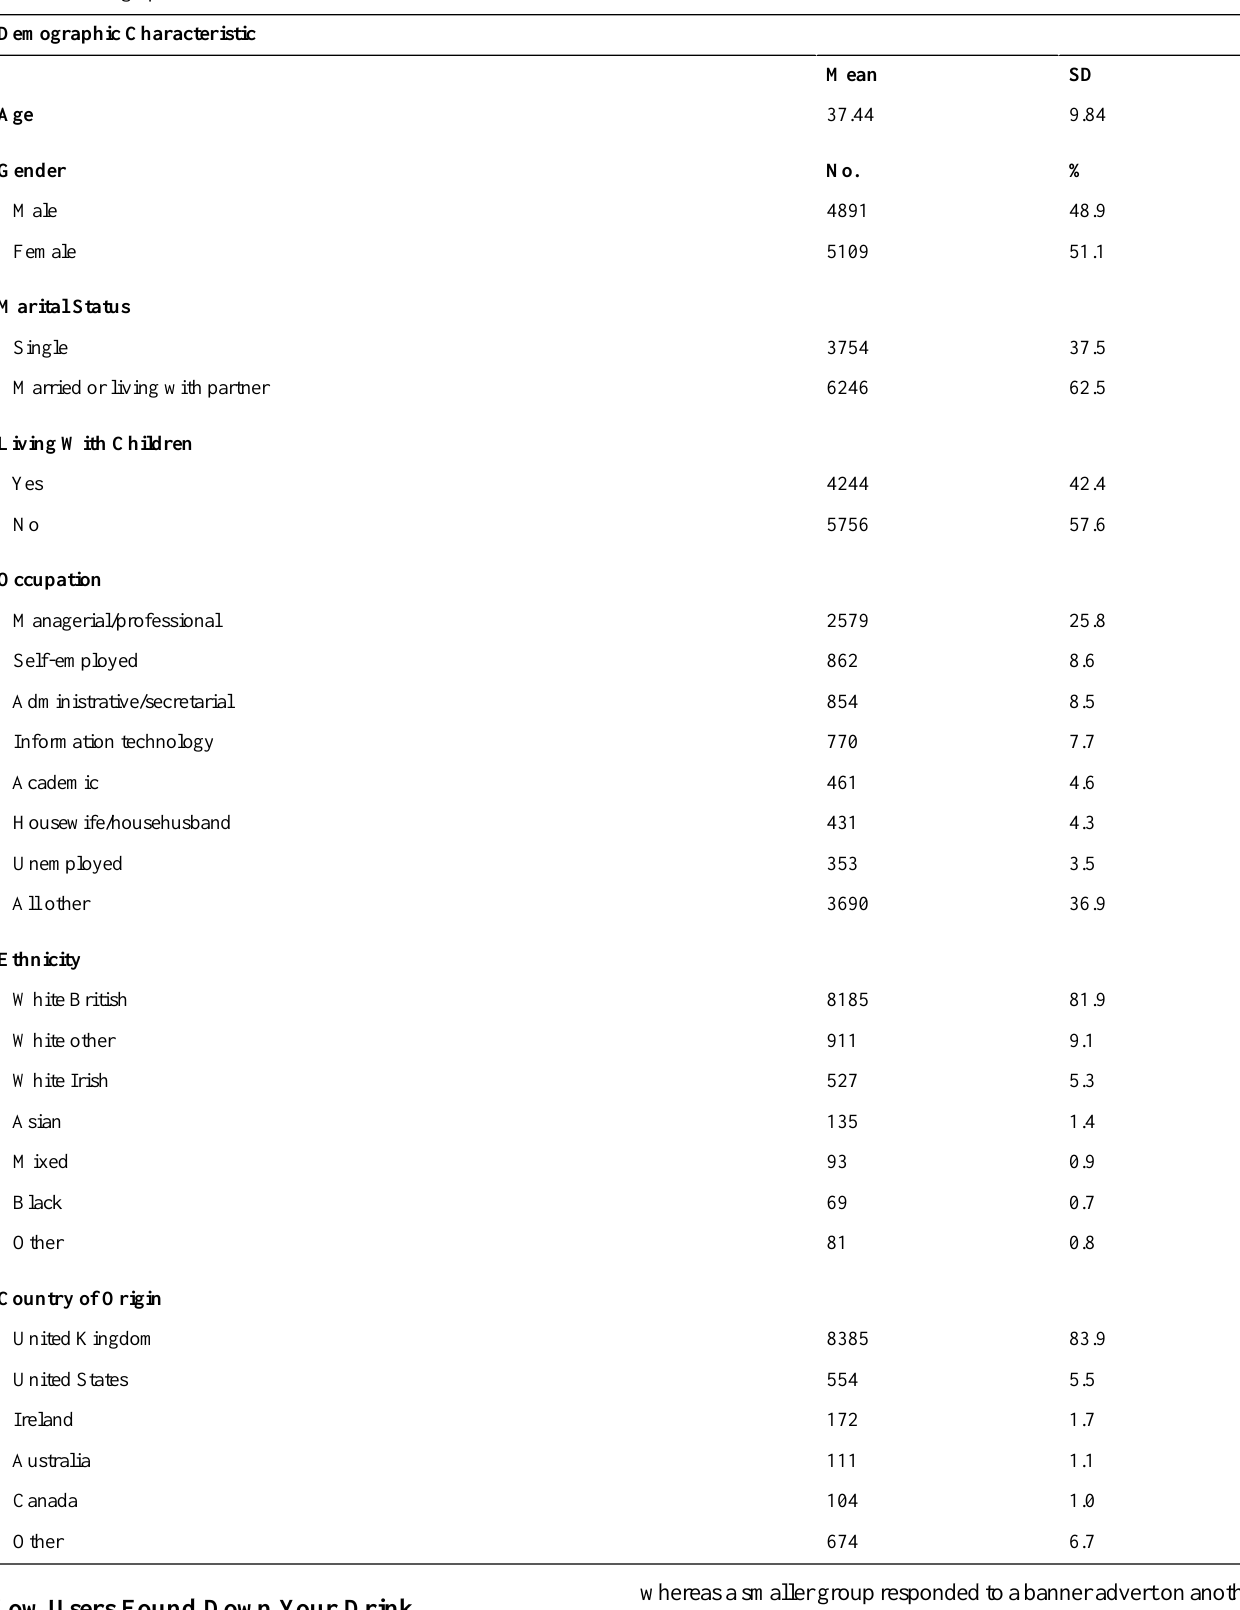
Table 1. Demographic characteristics of Down Your Drink users Demographic